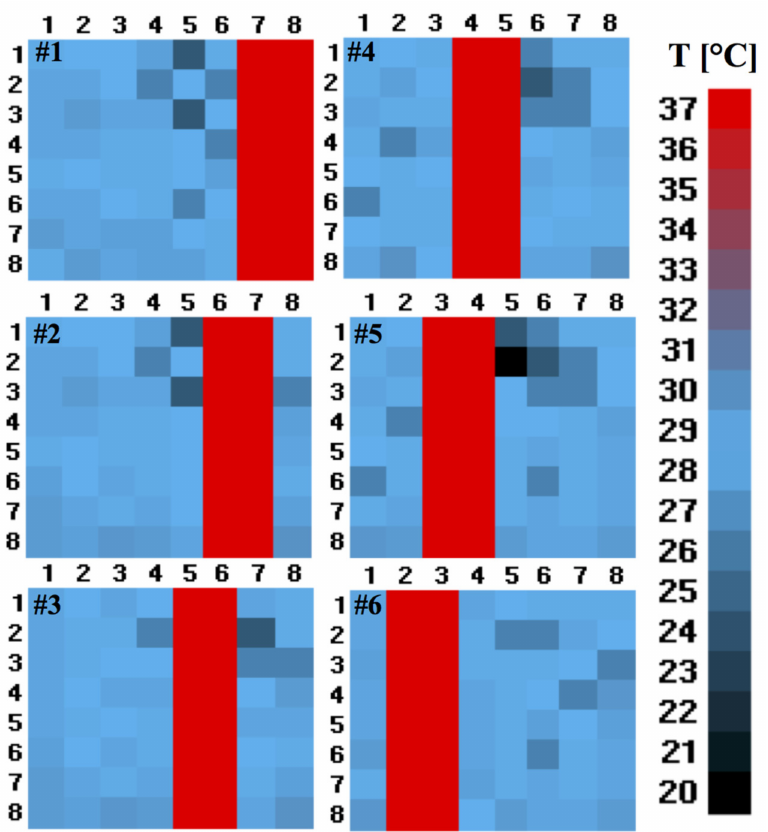
Figure 9. Representative illustration of “Step test” conducted with 6 frames. The step (perturbation) is shown in red, which scrolls from the right to left